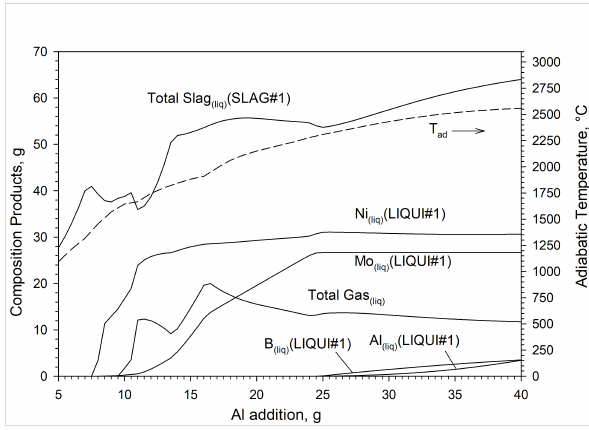
Figure 2: Selected phases and T ad values of an SHS process versus Al by FactSage Calculation (40 g MoO 3 +40 g NiO + 20 g B 2 O 3 + <